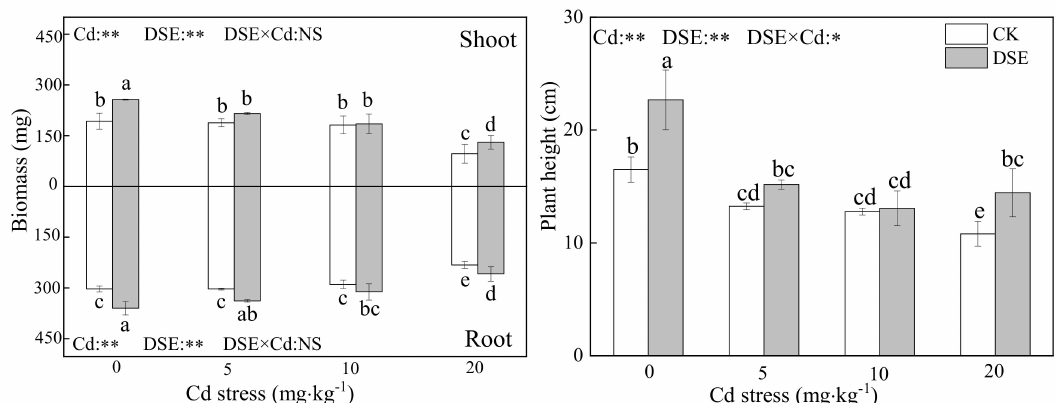
Figure 1. Effects of DSE inoculation on maize biomass and height under Cd stress. Error bar indicates standard deviation. Cd: cadmium treatment; CK: the control of non-inoculation; DSE: Exophiala pisciphila inoculation; different little letters refer to p < 0.05 according to LSD test. “NS”, “*”, and “**” mean no significance, p < 0.05 and p < 0.01 according to two-way ANOVA,